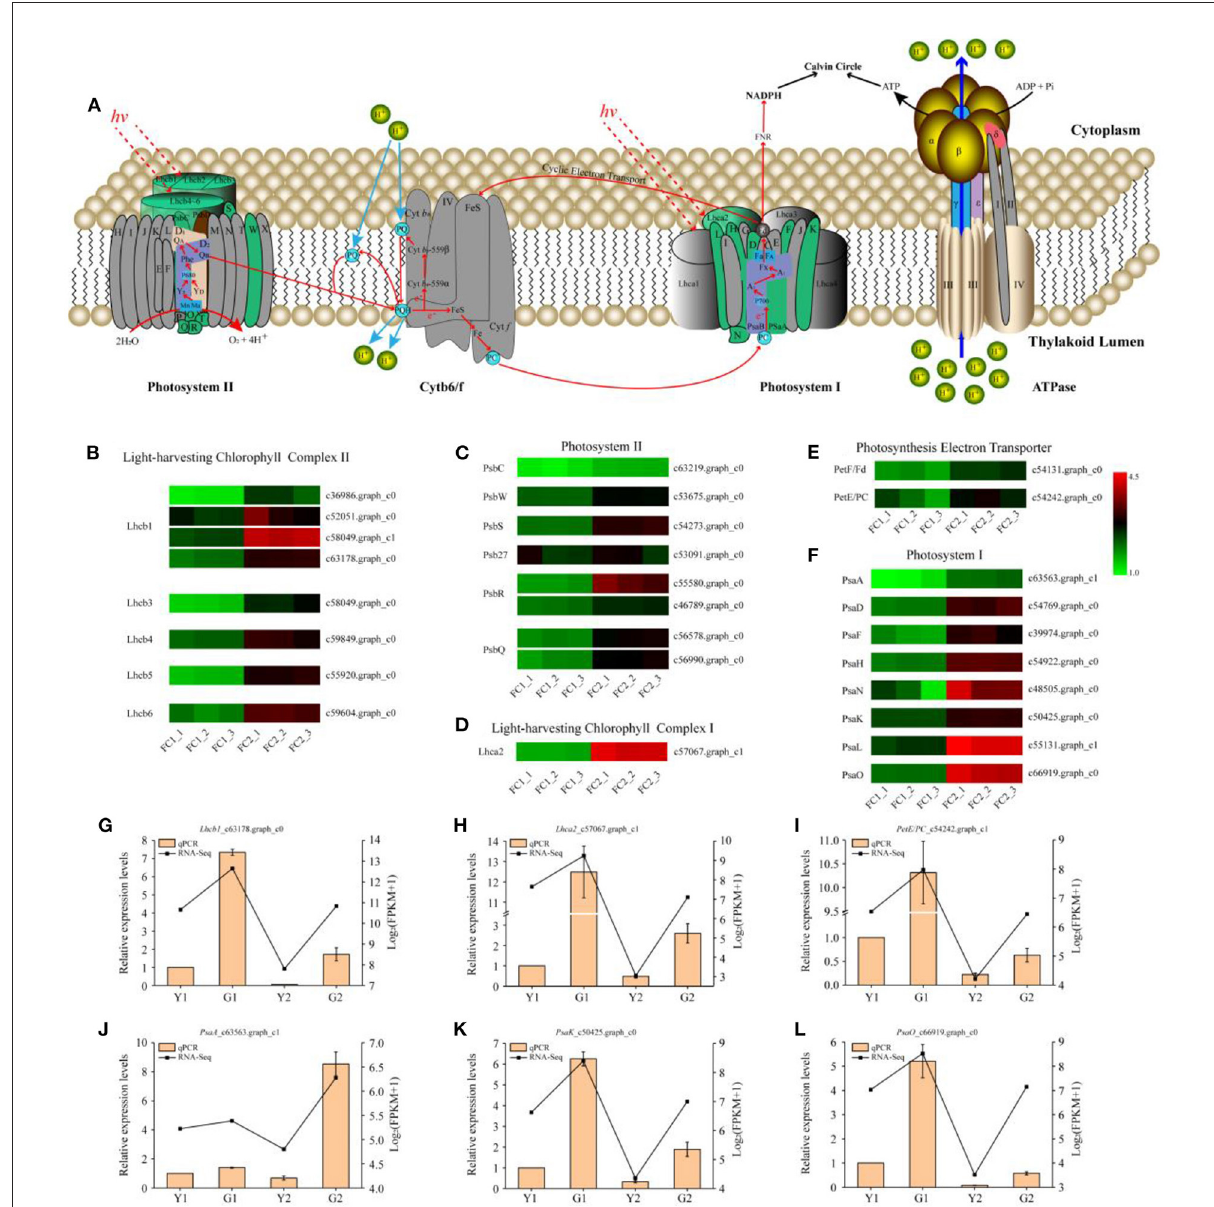
FIGURE4 DEGs predicted to be involved in photosynthesis metabolism. (A) Diagram of electron transport pathway in photosynthesis. (B–F) DEGs involved in light-harvesting chlorophyll complex II, photosystem II, light-harvesting chlorophyll complex I, photosynthesis electron transporter, and photosystem II, respectively. Lhcb light-harvesting complex II chlorophyll a/b binding protein, PsbC photosystem II CP43 chlorophyll apoprotein, PsbW photosystem II W protein, PsbS photosystem II 22 kDa protein, Psb27 photosystem II 27 protein, PsbR photosystem II 10 kDa protein, PsbQ photosystem II oxygen-evolving enhancer protein, Lhca light-harvesting complex I chlorophyll a/b binding protein, PetF/Fd ferredoxin, PetE/PC plastocyanin, PsaA photosystem I P700 chlorophyll a apoprotein A1, PsaD photosystem I reaction center subunit II, PsaF photosystem I subunit III, PsaH photosystem I reaction center subunit VI, PsaN photosystem I subunit N, PsaK photosystem I P700 chlorophyll a apoprotein A1, PsaL photosystem I reaction center subunit XI, PsaO photosystem I subunit O. (G–L) Relative expression of six selected